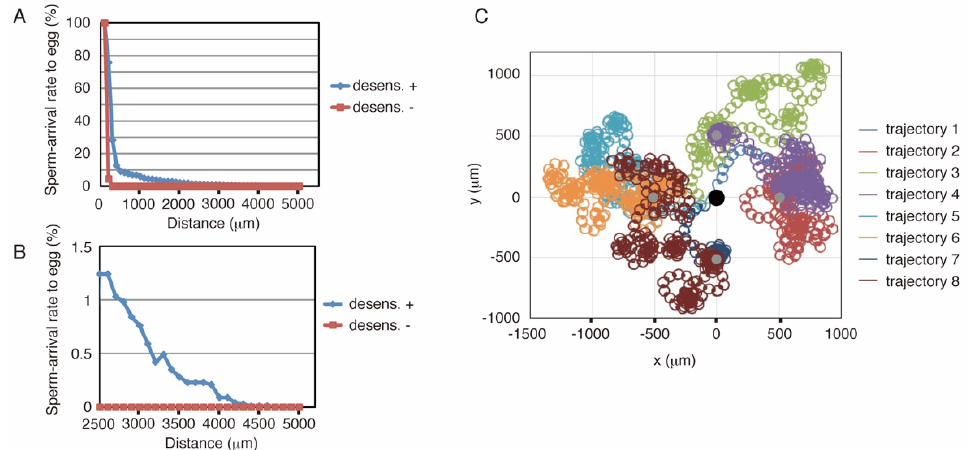
Figure 3. Result of simulations with starfish model. ( A , B ) Summary of the simulation results with the starfish model. The axes and colors are the same as in Figure 2A,B. ( C ) Representative trajectories in the simulation using the starfish model. The black circle indicates the egg, and the sperm started from the four gray circles. Trajectories 1 and 2, 3 and 4, 5 and 6, and 7 and 8 start from the same points. Trajectories 2, 4, 6, and 8 show successful examples, whereas the others represent failures.